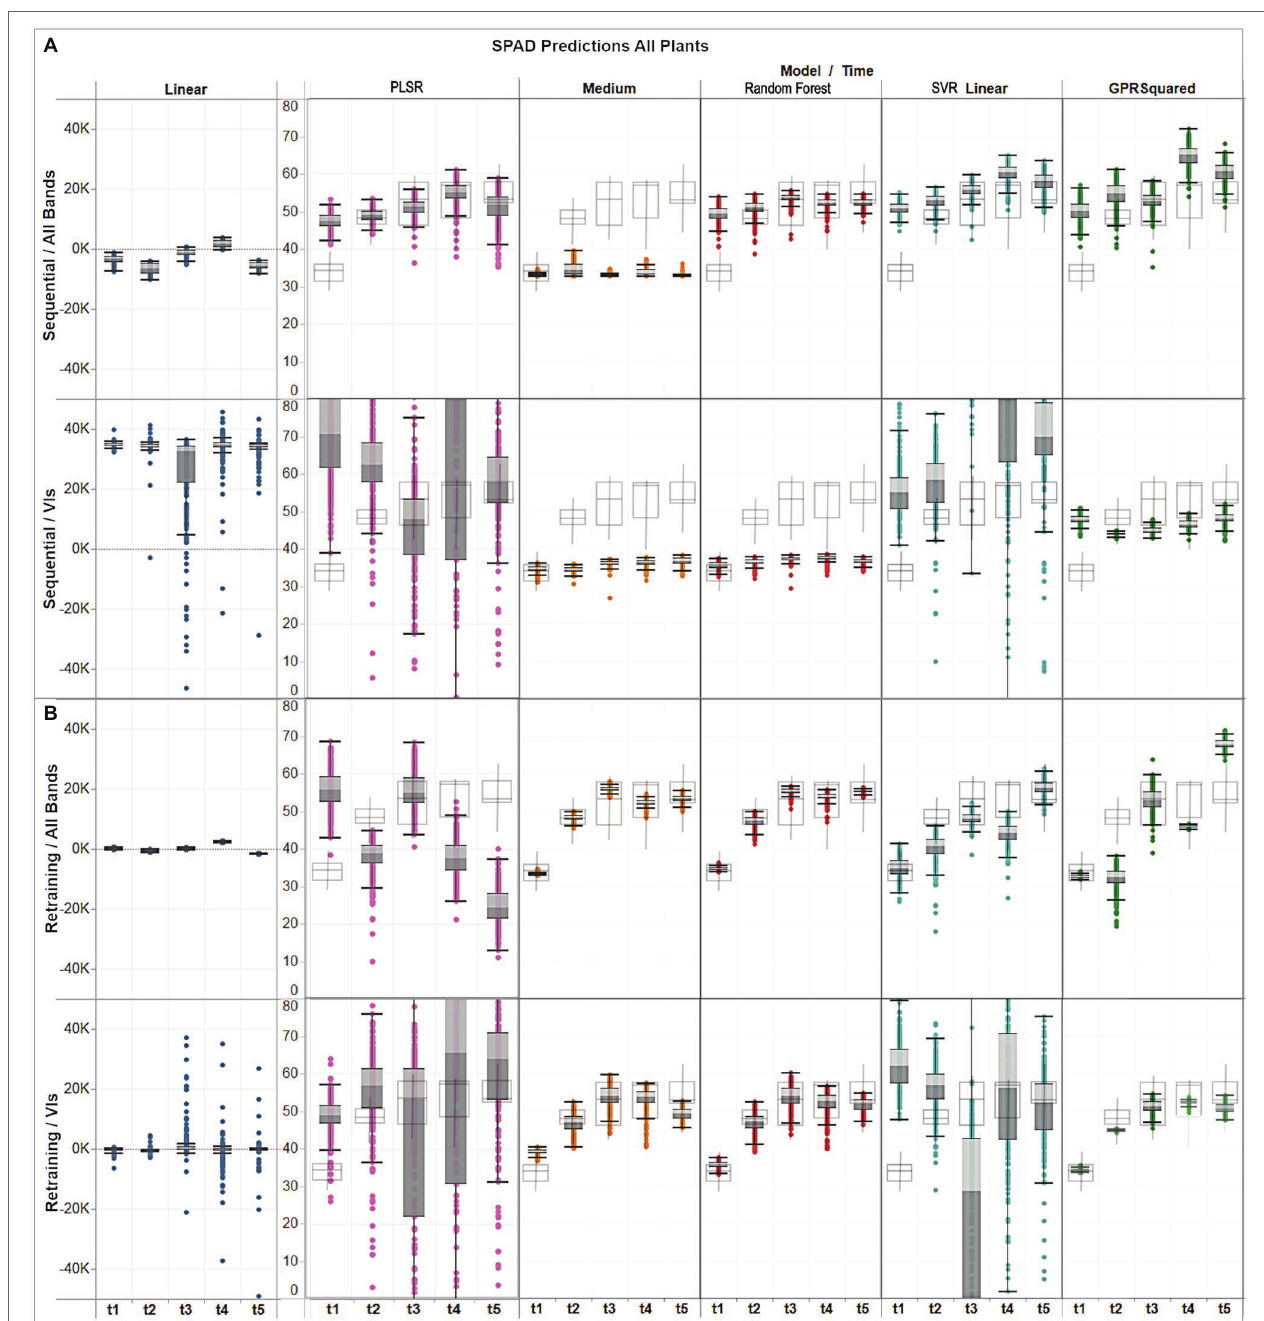
FIGURE 8 | Assessment of multi-temporal predictions distribution (gray colored boxes) against the actual distribution (gray delineated boxes) of the validation data, showing (A) distribution per model under the sequential strategy using band and VI predictors; and (B) distribution per model under the retraining strategy using band and VI